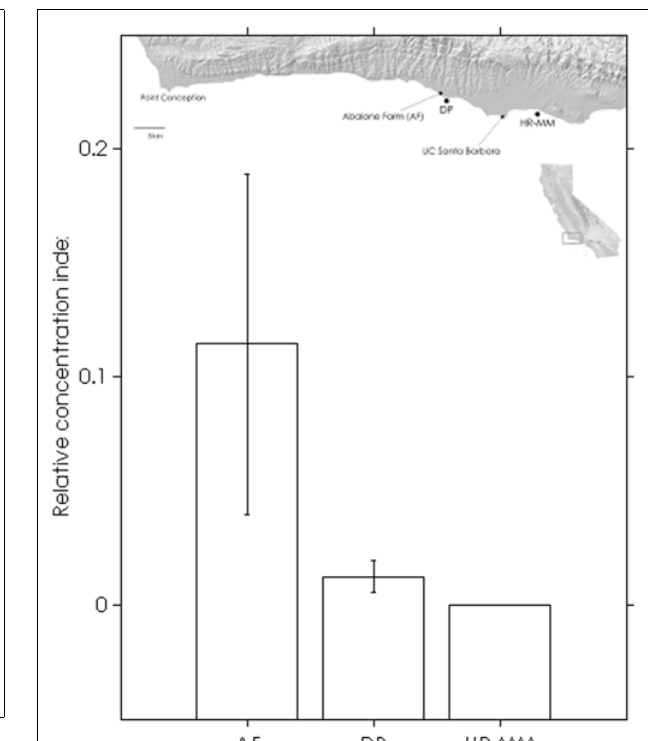
FIGURE 2 | Means ( ± SE) ofWS-RLO DNA relative concentration indices at the abalone farm (AF), Dos Pueblos (DP), and Hope Ranch-More Mesa (HP-MM), with a map of the sites. Long-shore current flows from left to right.The index describes the concentration ofWS-RLO DNA in seawater relative to pooled sample ofWS-RLO DNA taken from the post-esophagus ofWS-RLO infected red abalone with > 100WS-RLO inclusions per 200 × magnification field of